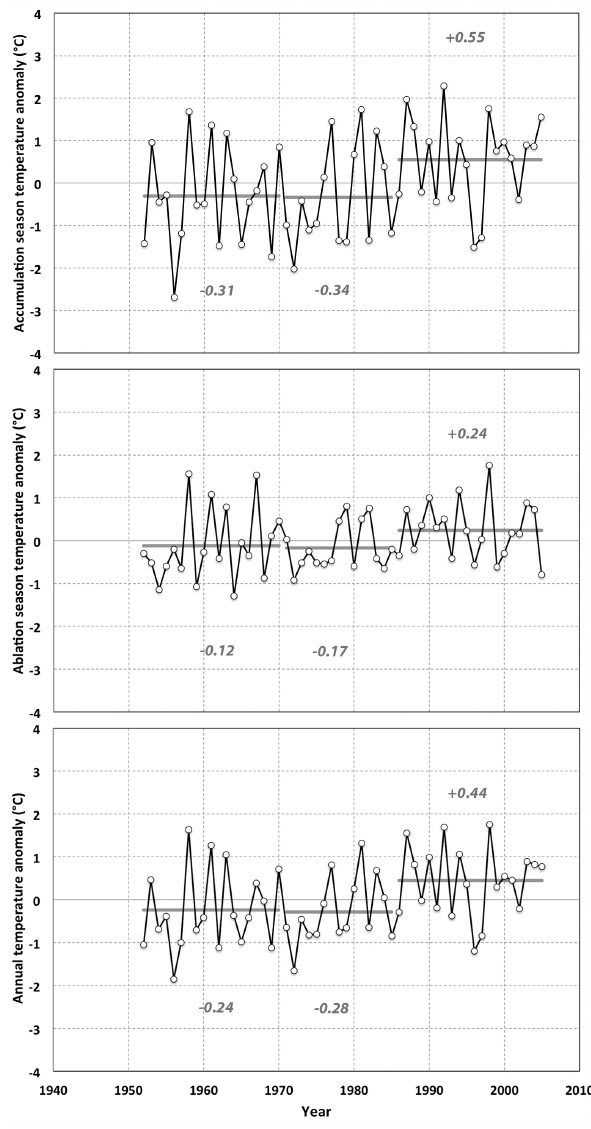
Figure 10. ClimateWNA temperature records of deviation from the long-term (1952–2005) mean of (a) average accumulation-season temperature, (b) average ablation season temperature, and (c) aver- age annual temperature. Gray bars and values indicate averages for the periods 1952–1970, 1970–1985, and 1985–2005.